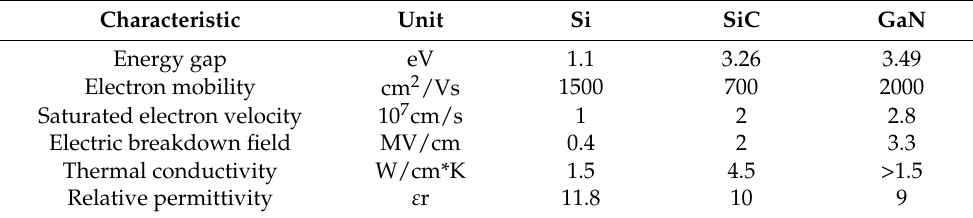
Table 1. Comparison of characteristic parameters for various semiconductor materials. Characteristic Unit Si SiC GaN Energy gap eV 1.1 3.26 3.49 Electron mobility cm 2 /Vs 1500 700 2000 Saturated electron velocity 10 7 cm/s 1 2 2.8 Electric breakdown field MV/cm 0.4 2 3.3 Thermal conductivity W/cm*K 1.5 4.5 >1.5 Relative permittivity ε r 11.8 10